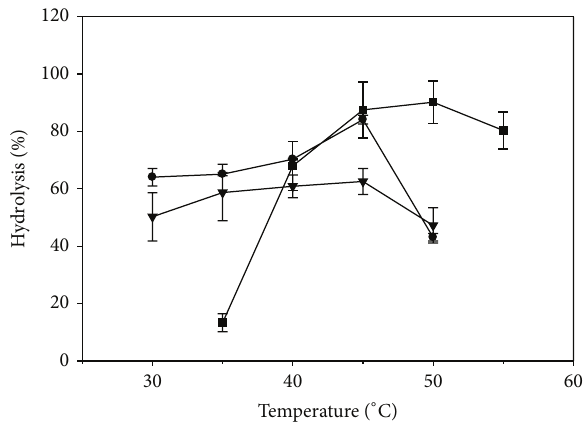
Figure 4: Effect of temperature on the hydrolysis of safflower oil, using lipases from Candida rugosa type VII (CRL) ( e ), porcine pan- creastypeII(PPL)( 󳶃 ),and Thermomyceslanuginosus (LipozymeTL IM) ( ◼ ). The optimal biocatalyst amount was 1.3 and 2.0 mg solid enzyme/mL reaction mixture for CRL and PPL, respectively, and 3.3 mg granular enzyme/mL reaction mixture for Lipozyme TL